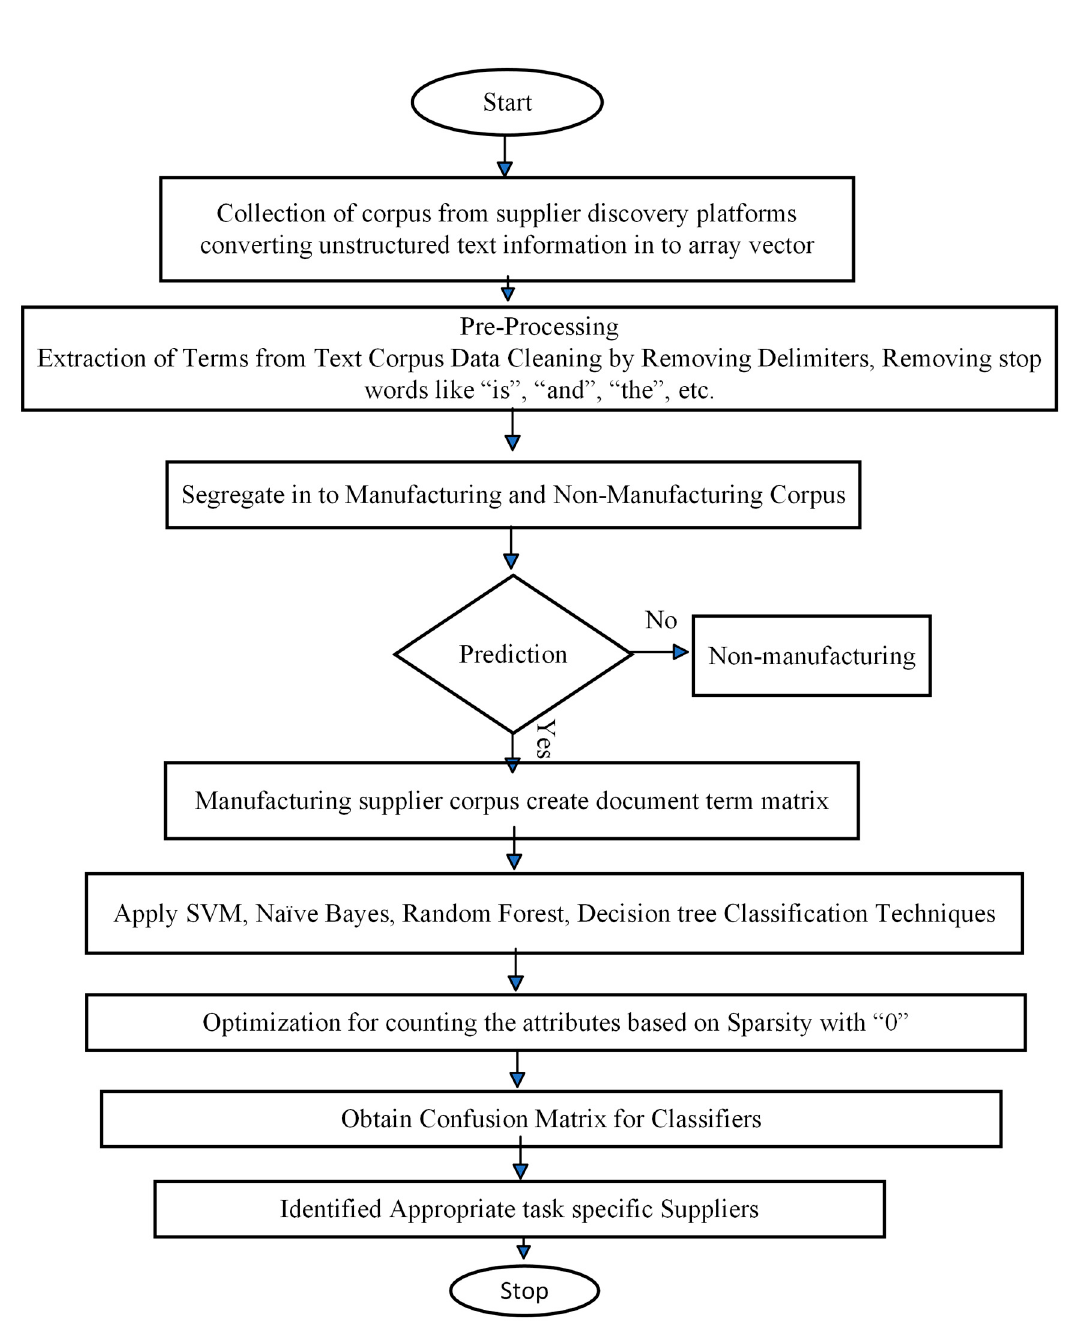
Figure 3. Flowchart for the proposed text-mining approach.